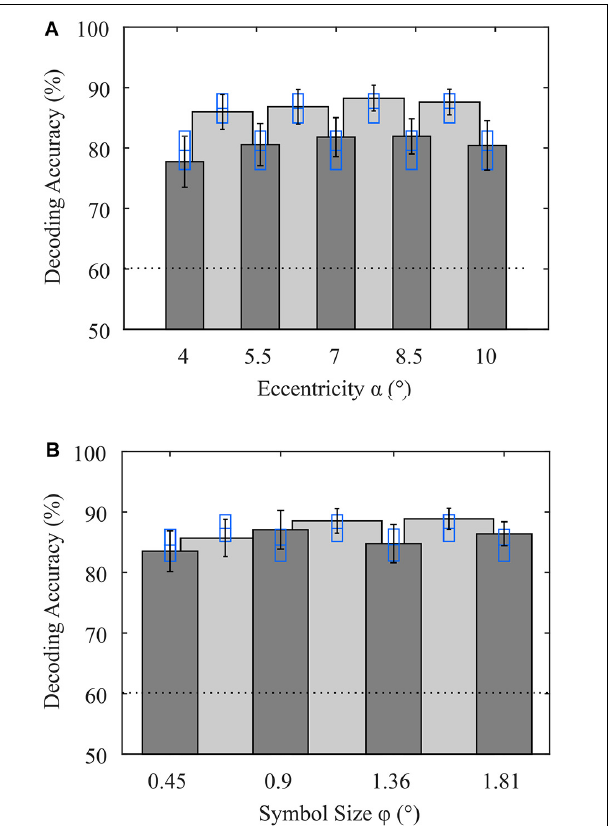
FIGURE 4 | Average decoding accuracies achieved with variations in stimulus features (A) eccentricity and (B) symbol size. Dark gray bars indicate that only trials with that parameter (eccentricity or symbol size) were included in the analysis, but the other parameter varied (symbol size or eccentricity). Light gray bars indicate that in the analysis, trials associated with the two adjacent visual angles were included (e.g., 4 ◦ and 5.5 ◦ ). Error bars indicate the standard error of the mean. Blue rectangles indicate the mean and the standard error of accuracies achieved with all stimulus features involved but sample sizes of the training data sets matched. The dotted line denotes the upper bound of the guessing level, as determined using a permutation